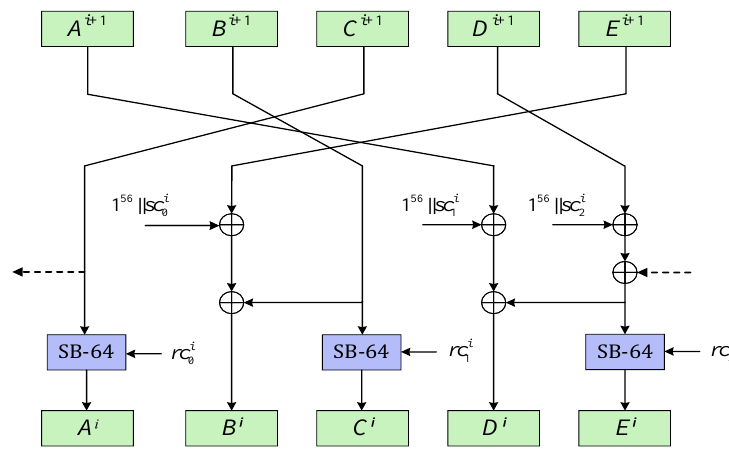
Figure 3. ACE Inverse Step